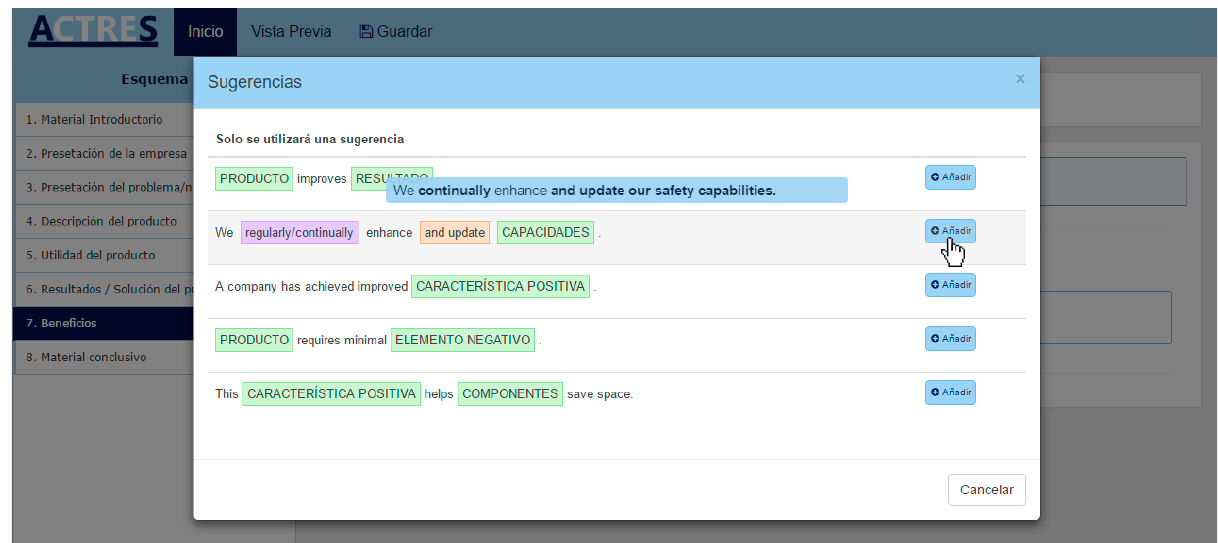
Figure 5. Suggestions of O-WEAA’s Writing Assistant Interface Module When a specific model line is selected by clicking on it, the model line appears in the drafting area below to be completed and edited by the user as required, as shown in Figure 6 .